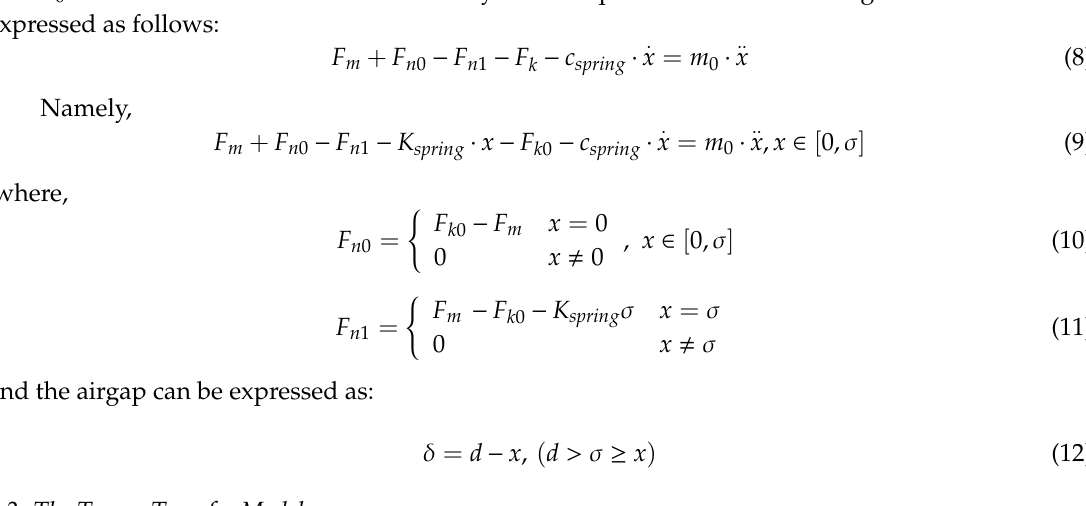
Figure 9. Schematic diagram of electromagnetic actuator. x -the displacement of the armature, d -the original airgap between the electromagnet and the armature, σ -the free travel of the primary clutch plates with the electromagnet force absent, F m -the spring force, F n 0 -the force exerted by the spring base at the original position, F n 1 -the compression force of the clutch when engaged, F the original spring force, K as the stiffness of the spring, c 0 k spring spring